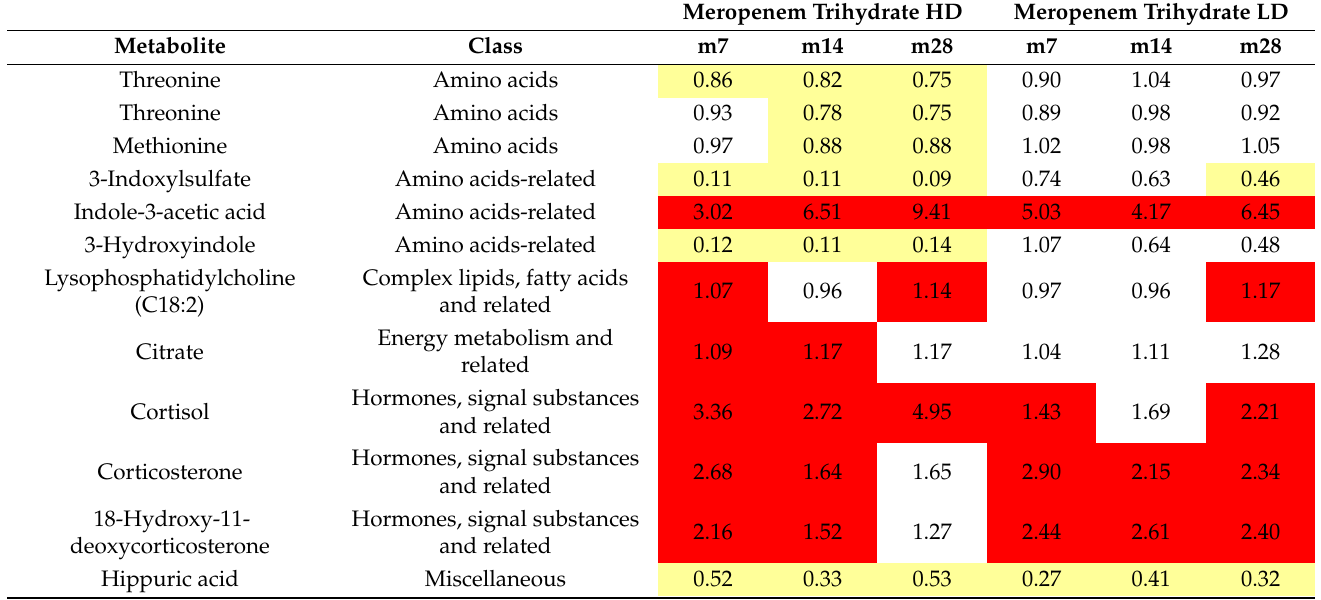
Table 8. Meropenem-induced plasma metabolite fold changes in male (m) Wistar rats (N = 5 per group) dosed with 100 (LD) and 300 (HD) mg/kg bw/day observed on 7, 14, and 28 days (m7, m14, and m28). Statistically significant changes (Welch t -test; p -value < 0.05) are shown where red boxes mean a significant increase in the respective plasma metabolites and yellow boxes mean a significant reduction compared to control levels.